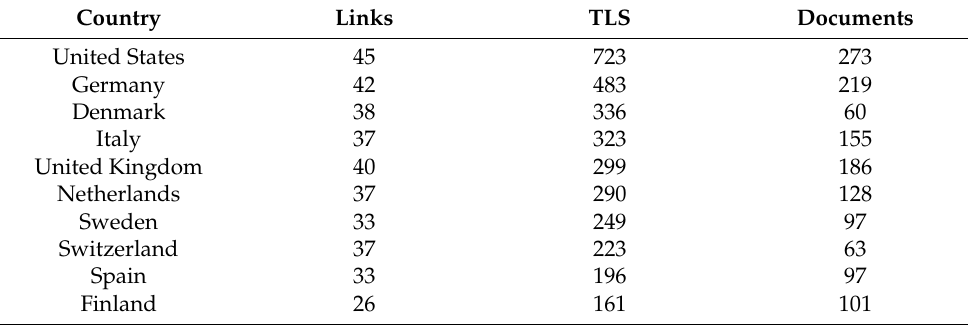
Table A4. Structural bibliometric indicators for the top ten countries included in the citation network (ranked by TLS).